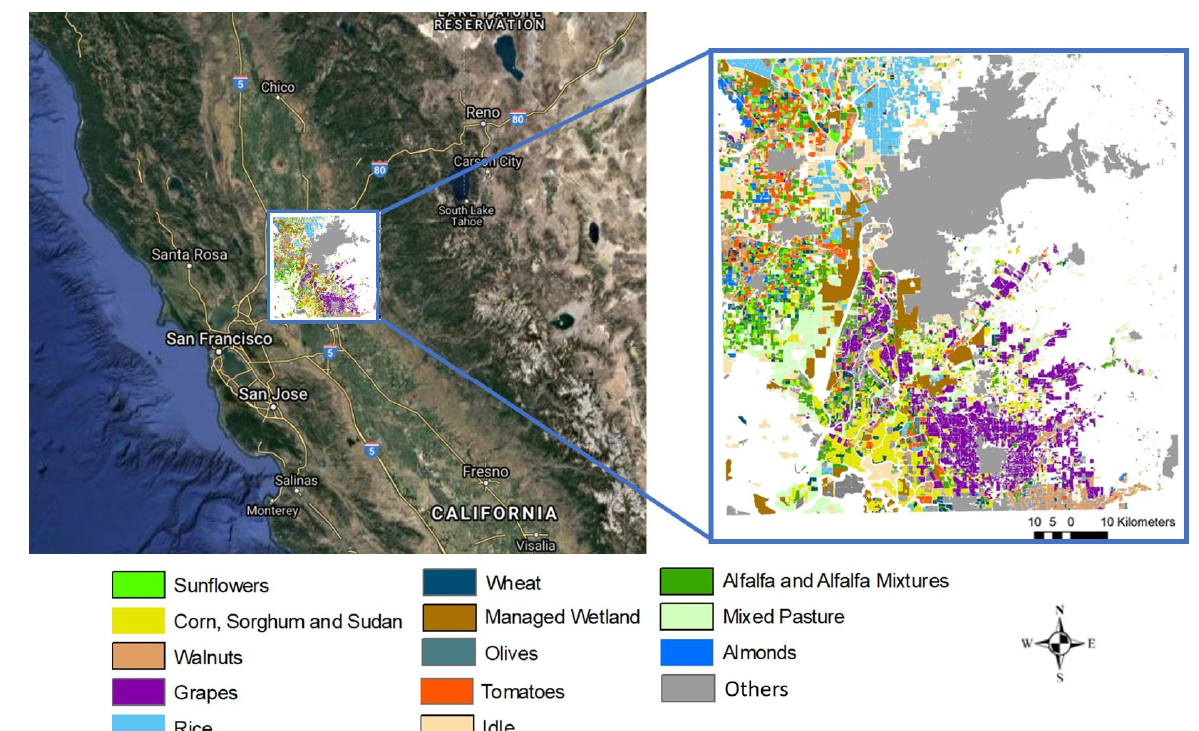
Figure 1. Study area in the Central Valley of California, USA (left) and land-use classes from the CROP2014 dataset (right).